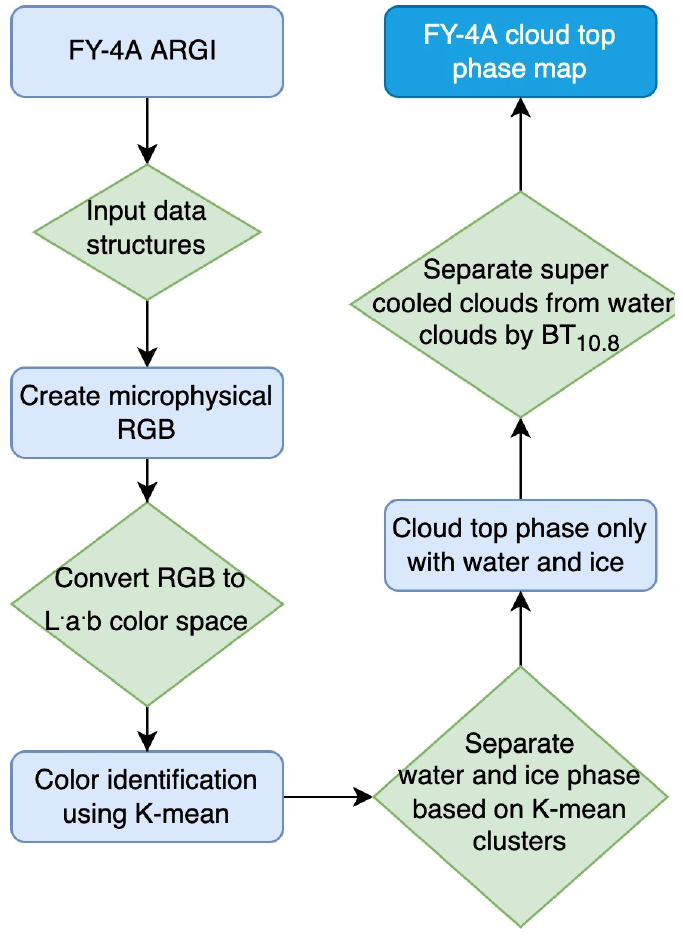
Figure 3. FY-4A cloud top phase retrieval algorithm general logic flowchart.